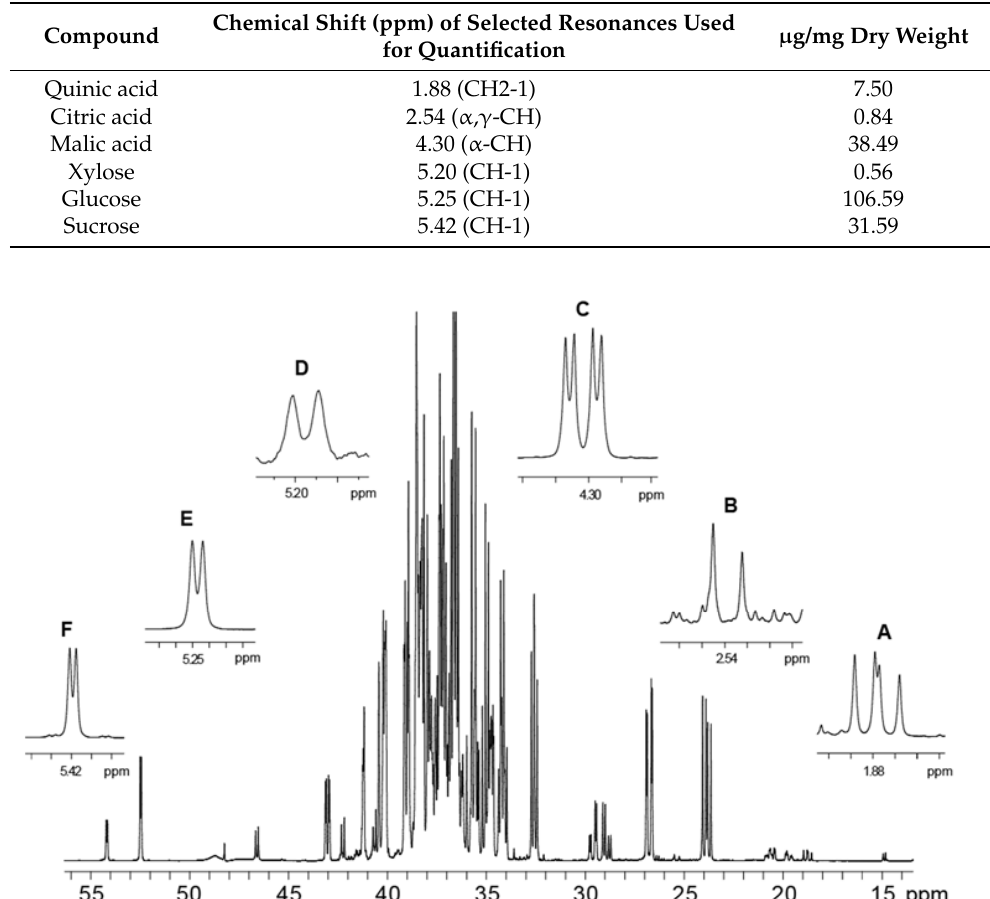
Figure 3. 1 H NMR spectrum of P. domestica subsp. syriaca fruit pulp extract. Quantified selected NMR signals are reported in expanded regions. ( A ) CH2-1 protons of quinic acid (1.88 ppm), ( B ) α , γ -CH protons of citric acid (2.54 ppm), ( C ) α -CH proton of malic acid (4.30 ppm), ( D ) CH-1 proton of in α -xylose (5.20 ppm), ( E ) CH-1 proton of α -glucose (5.25 ppm), ( F ) CH-1 proton of sucrose (5.42 ppm).